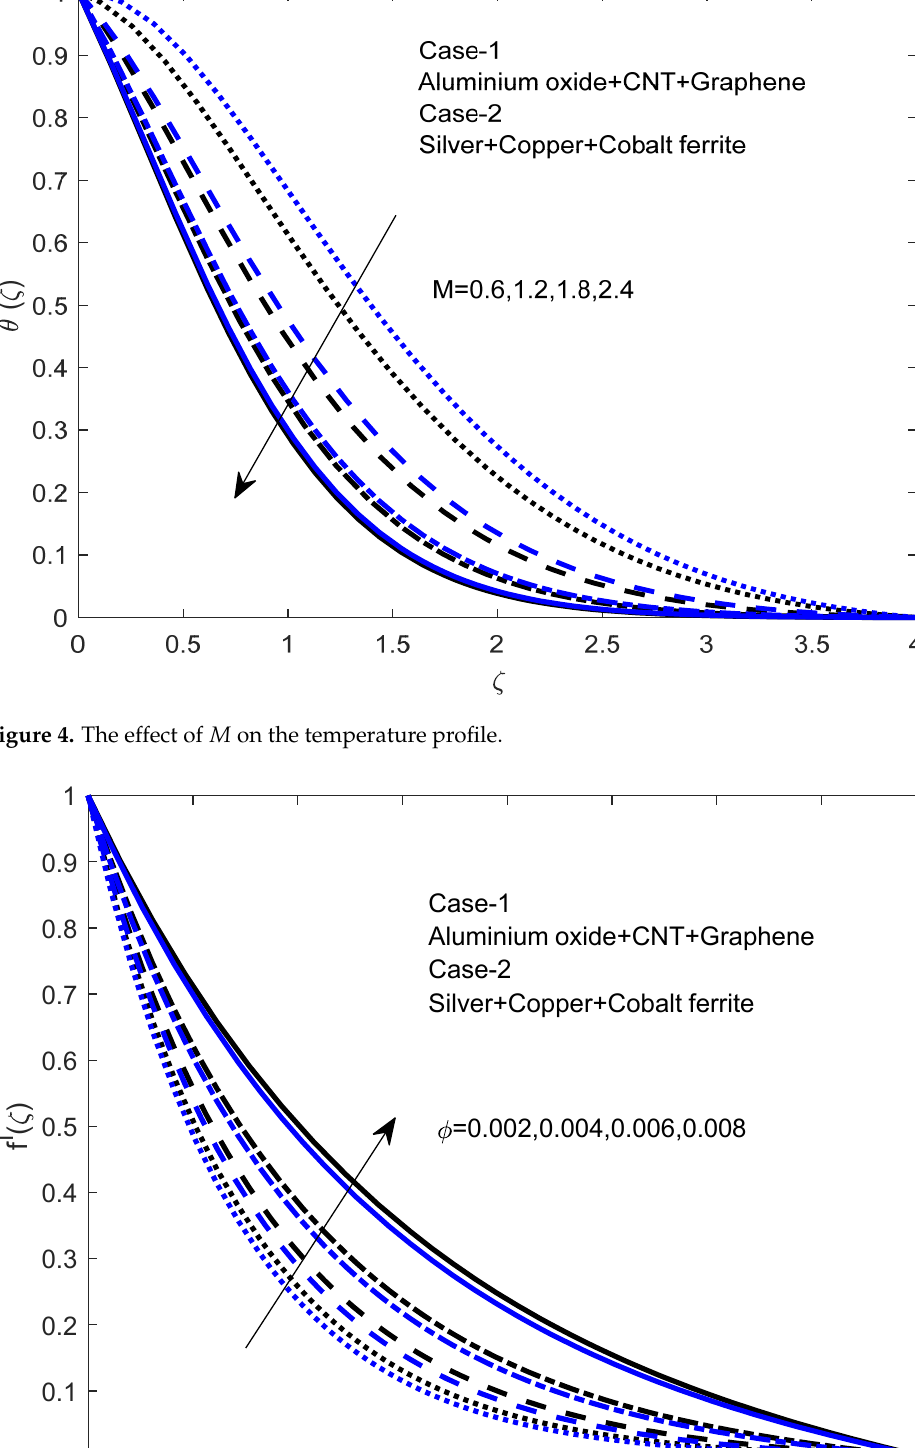
Figure 5. The effect